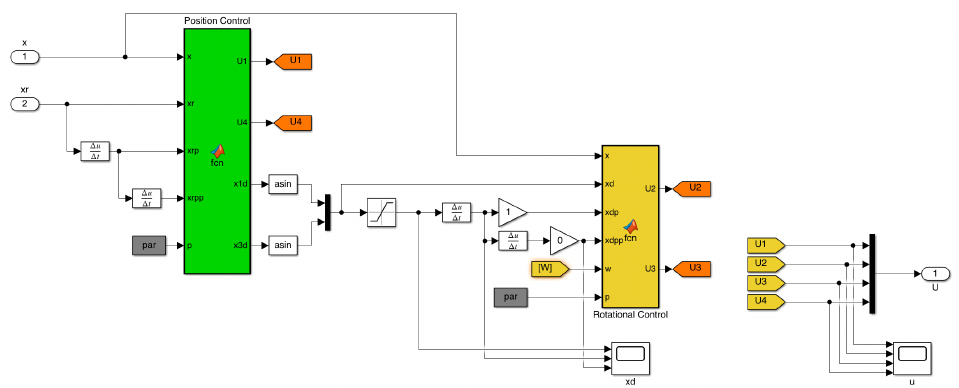
Figure 7. Control scheme for a quadrotor in